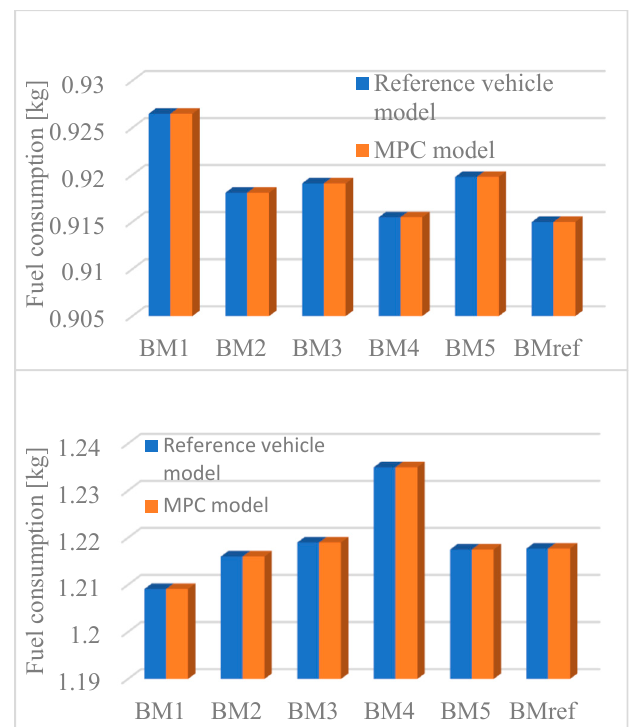
Figure 11. Fuel consumption comparison at the end of the two UDDS ( up ) and HWFET ( down ) drive cycles.